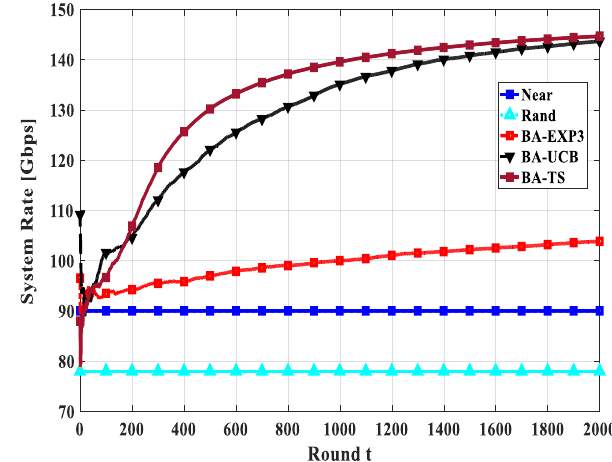
Figure 12. The convergence of system rate using access UAVs of 40, gateway UAVs of 20, and a beam-width of 60°.